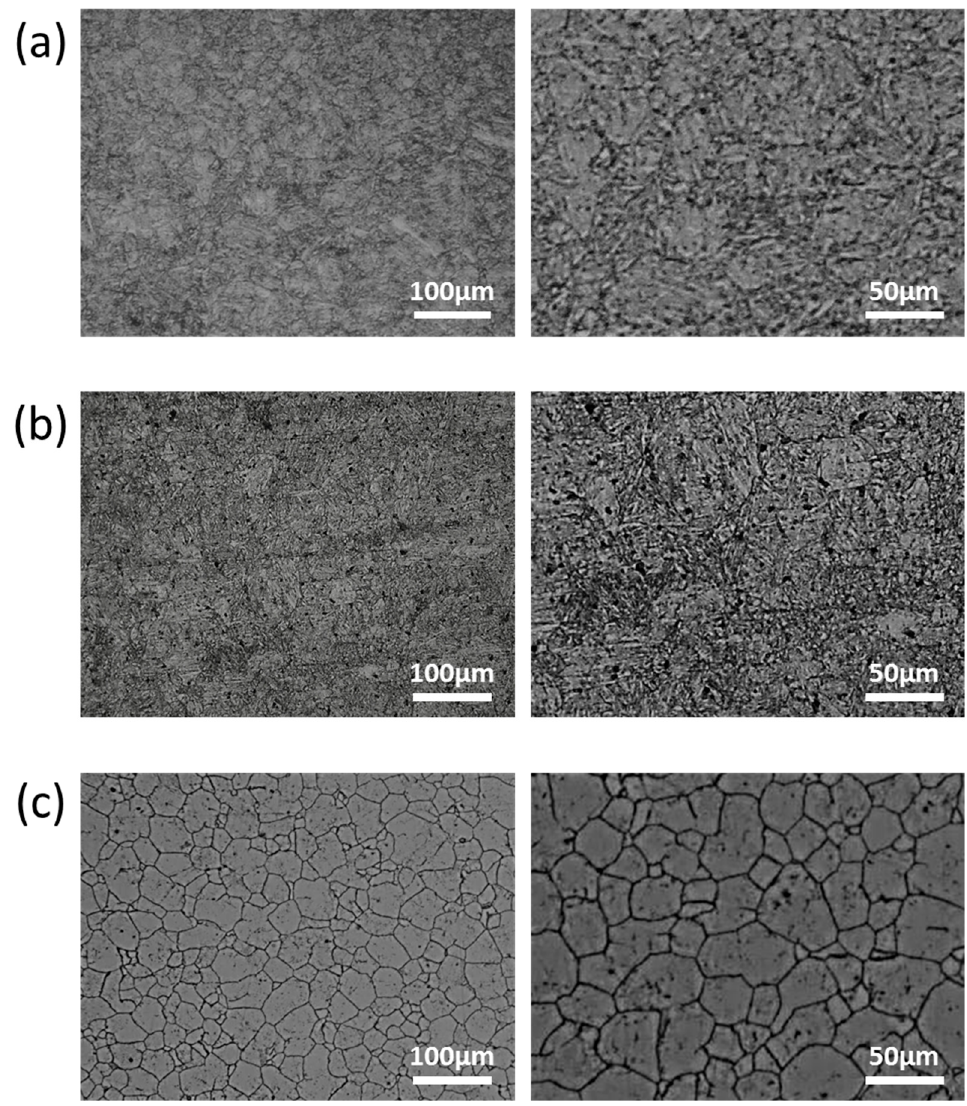
Figure 3. Microstructure of ( a ) T91, ( b ) HT9, and ( c ) SS316L before exposure to LBE. Left: 20× magnification, right: 80× magnification.